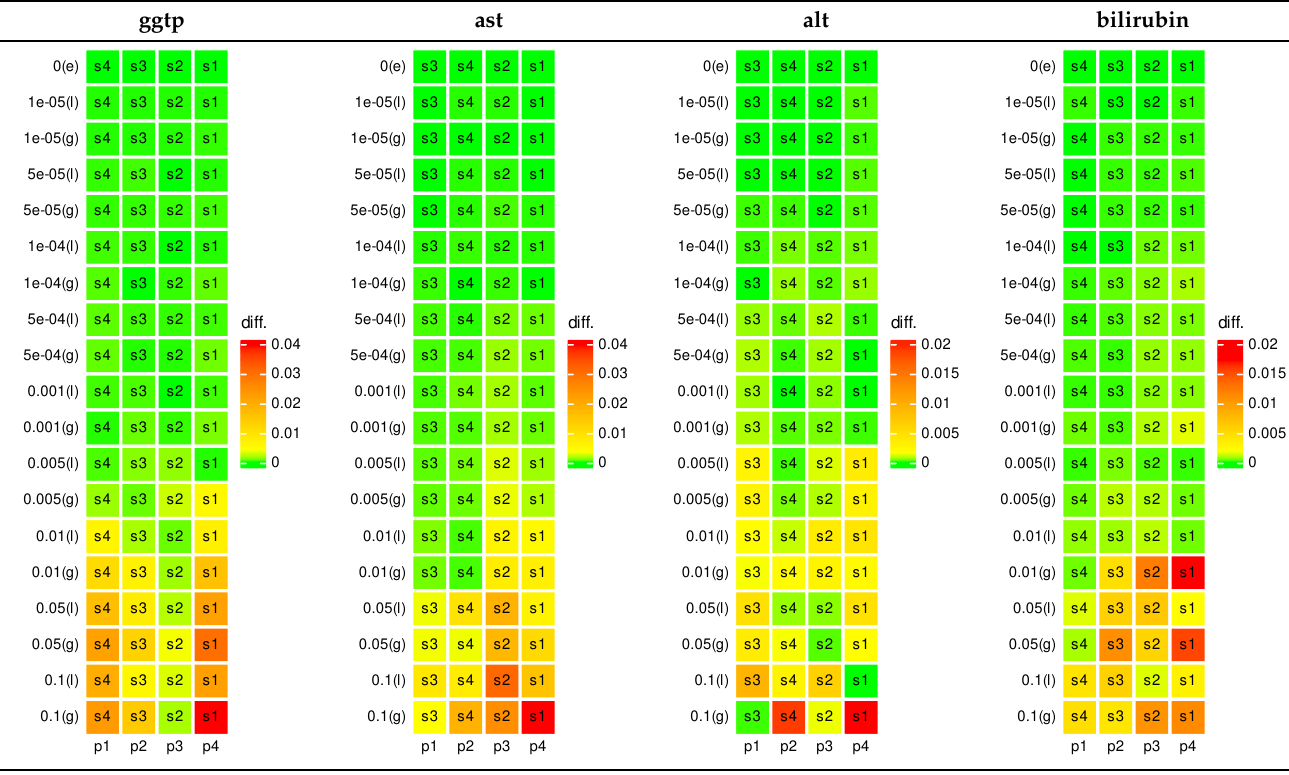
Table 16. Preferences for hepar2